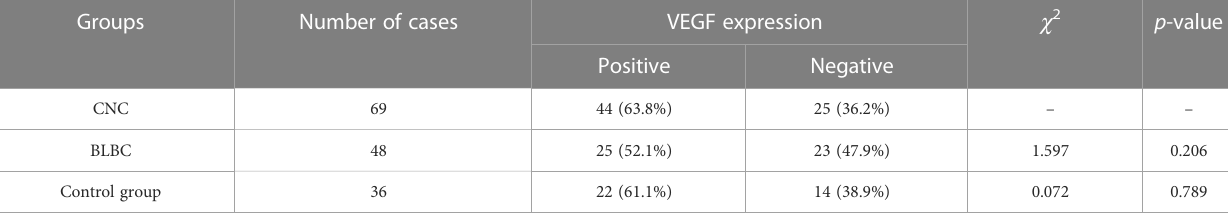
TABLE 5 Comparison of VEGF expression differences between CNC and BLBC and CNC and control group. Groups